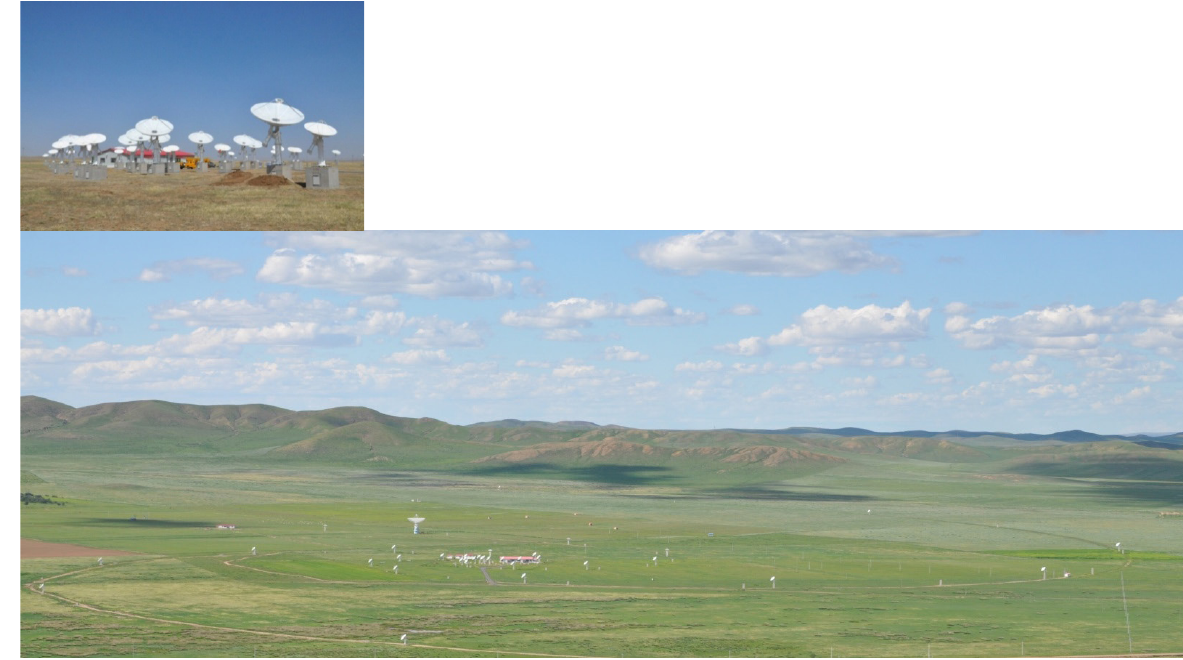
Figure 6. The CSRH Array